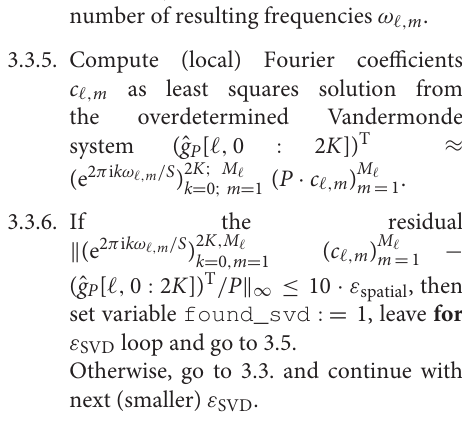
Algorithm 6.1 (Detailed listing of Algorithm 3.2 with